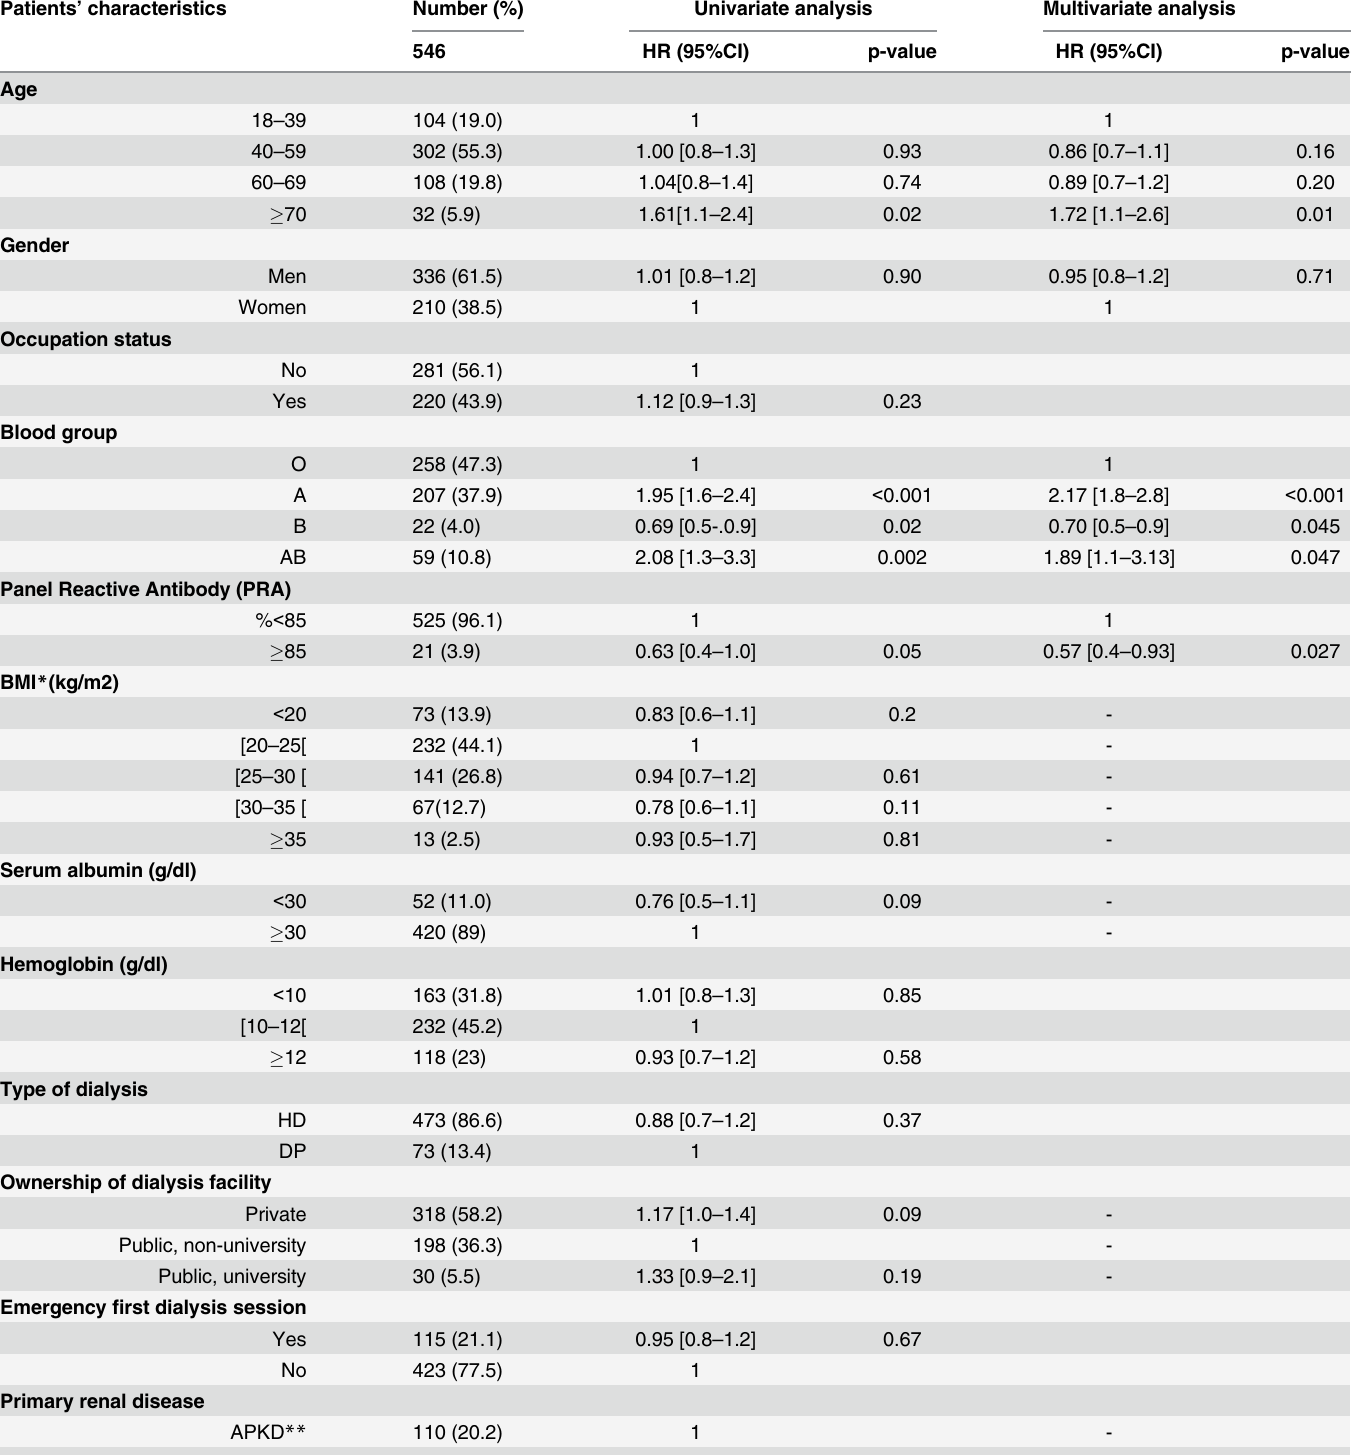
Table 2. Association between patients ’ characteristics and access to renal transplantation after placement on the waiting list (univariate and multi- variate Cox analyses). Patients ’